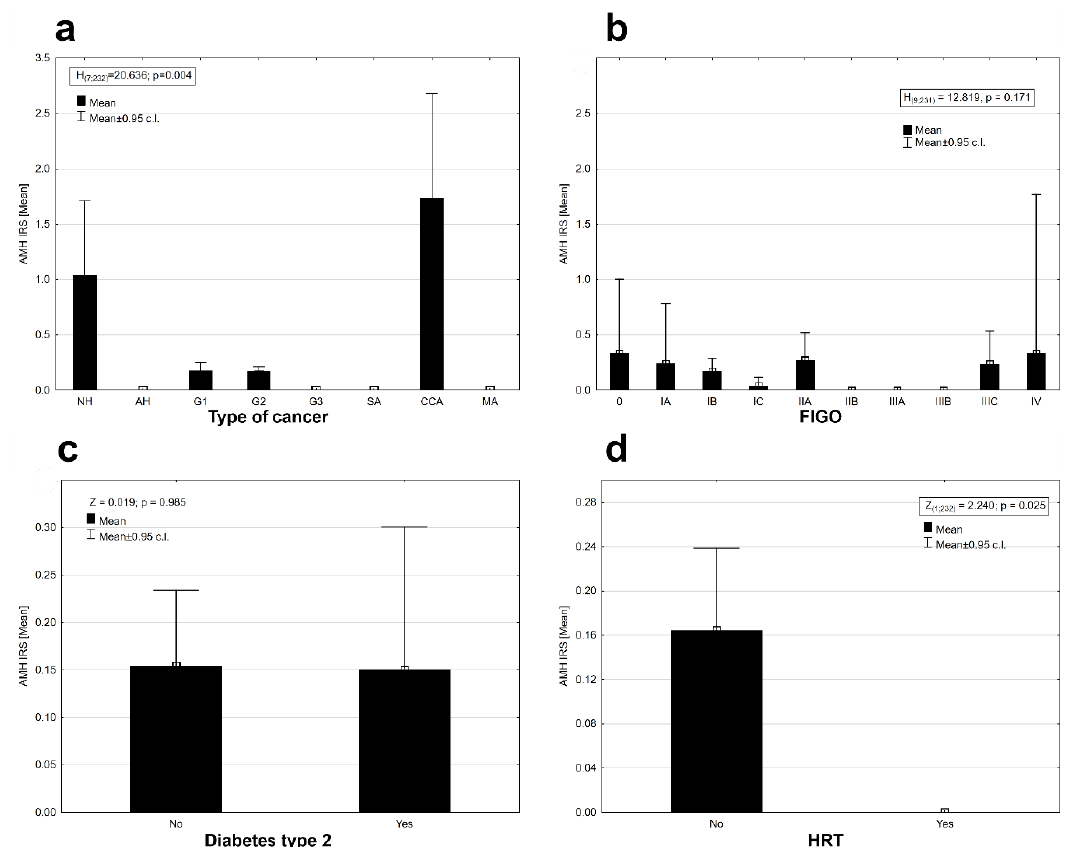
Figure 2. Mean AMH expression in: ( a ) different types of endometrial lesion (description of histopathological groups: NH — nonatypical hyperplasia, AH — atypical hyperplasia, G1 — well differentiated endometroid adenocarcinoma, G2 — moderately differentiated endometrioid